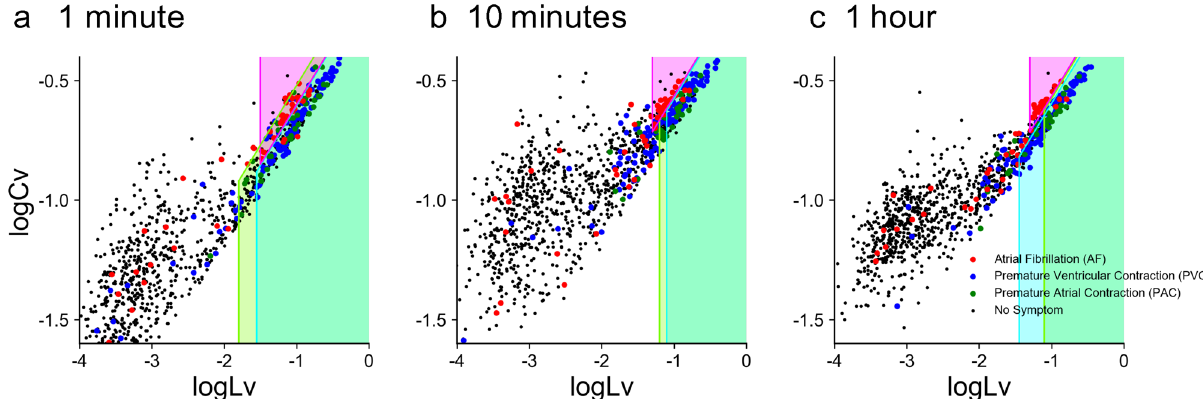
Figure 5. Two metrics log 10 Lv and log 10 Cv computed from shorter recording periods. ( a ), ( b ), and ( c ) Datasets of 1 minute, 10 minutes, and 1 hour, plotted on a plane spanned by log 10 Lv and log 10 Cv . The parameters a and b of each prediction zone were adapted to respective datasets.